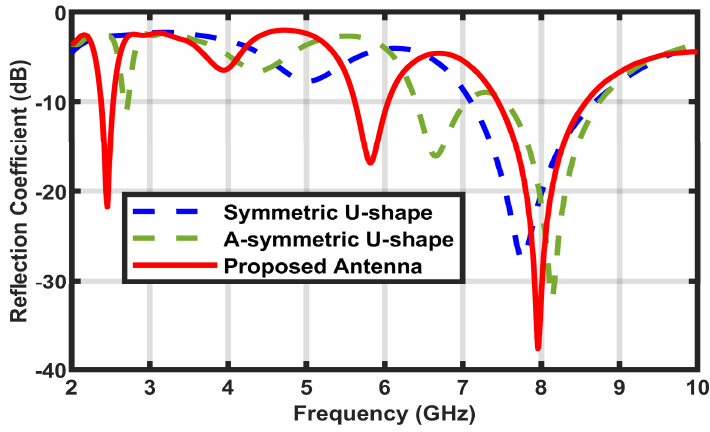
Figure 3. The return loss of the proposed antenna at various design steps.